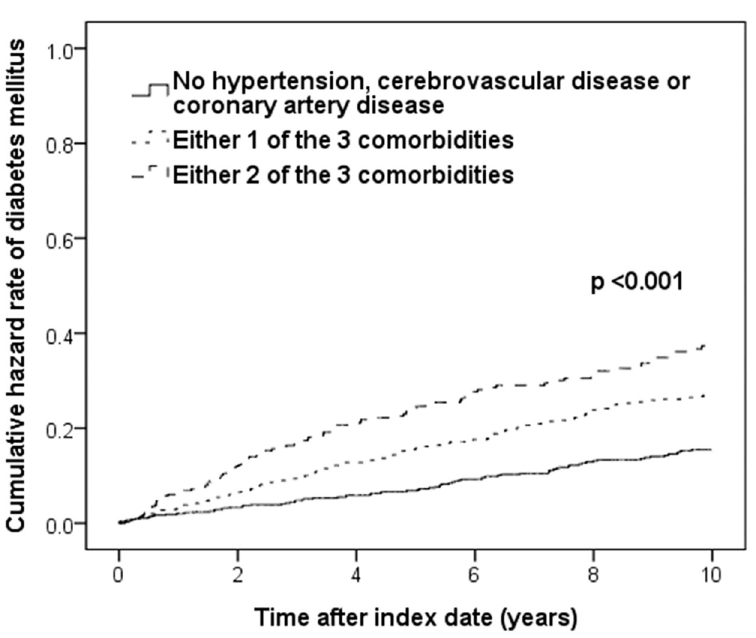
Fig 3. Cumulative hazard rate of incident DM in COPD patients according to comorbidity status (n = 1568). COPD, chronicobstructive pulmonary disease;DM, diabetes mellitus.